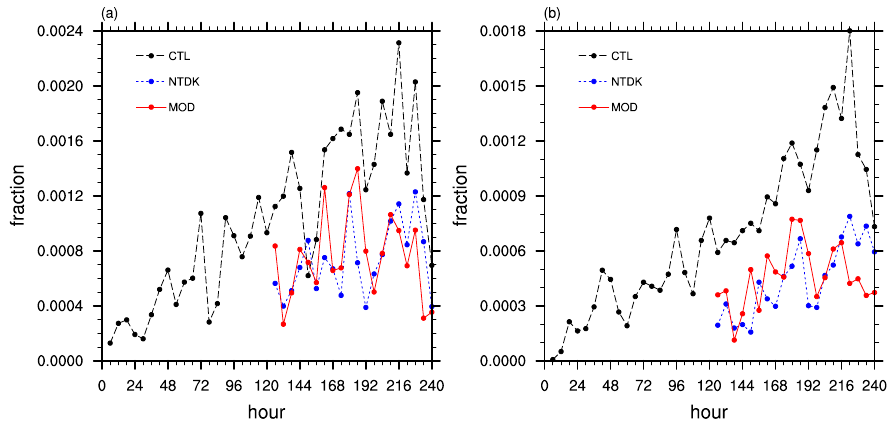
Figure 3. Time series of ( a ) the fraction of grid columns where the maximum vertical velocity is larger than 1 m s − 1 and ( b ) the fraction of grid columns where the six-hour accumulated grid-scale precipitation amount is larger than 80 mm in the selected domain (100° E–160° W, 0–50° N) from the CTL (black dashed), NTDK (blue dotted), and MOD (red solid)